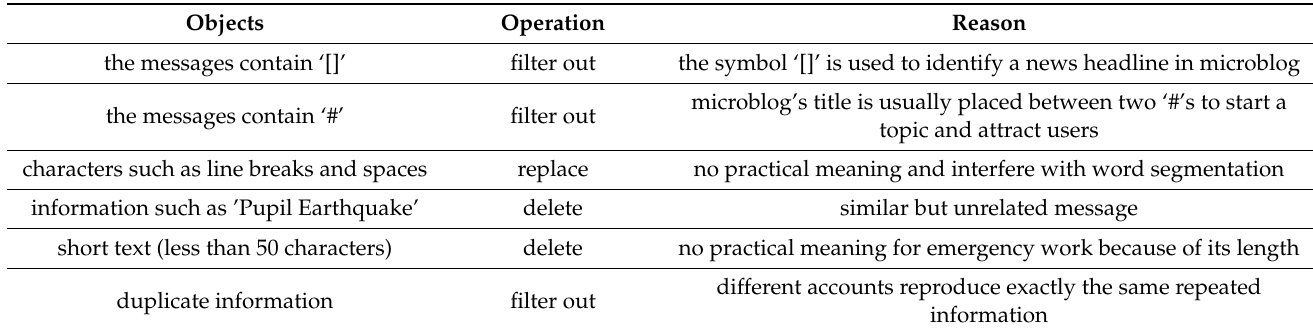
Table 2. Cleaning principles and processing methods for microblog